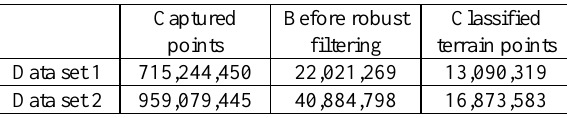
Table 1. Number of points before and after filtering